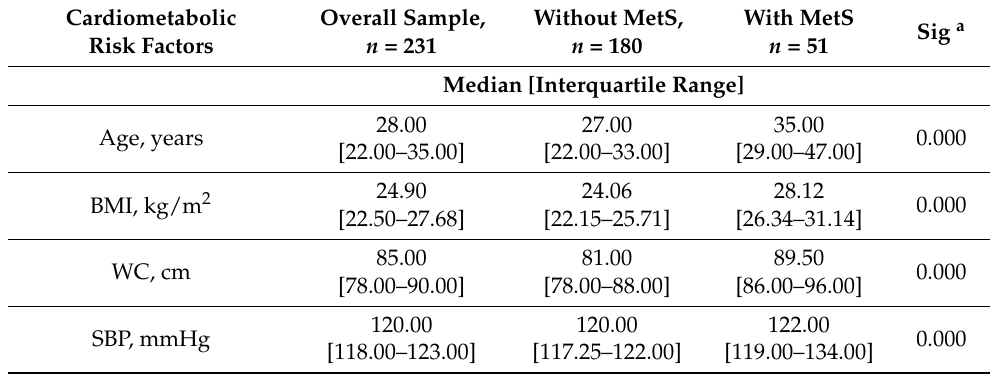
Table 4. Cardiometabolic factors among study